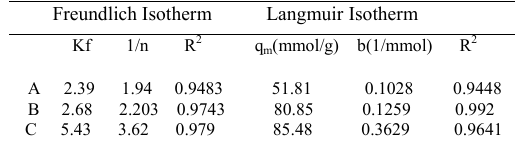
Fig. 7. Effect of contact time on the adsorption of phenylala - nine: (A) uncoated